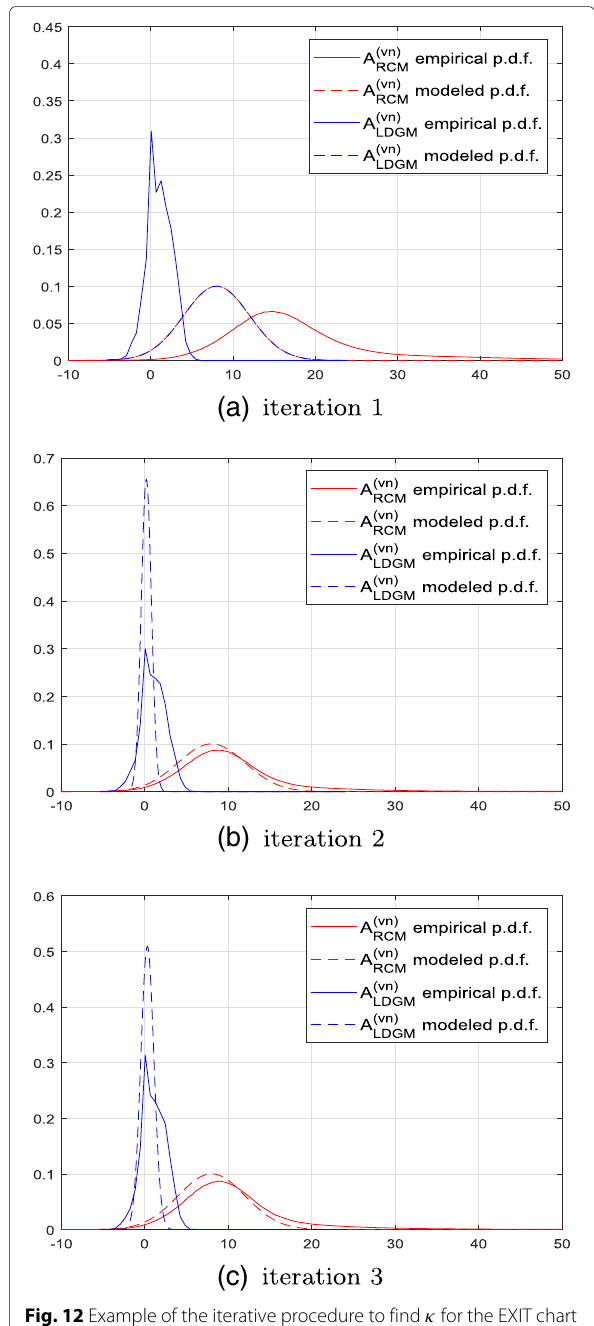
Fig. 12 Example of the iterative procedure to find κ for the EXIT chart of Fig. 8c. The histograms (conditioned to U = 1) obtained by Monte Carlo simulations are plotted in blue and the corresponding modeled conditional PDFs in red (refer to (11) and(12)). a Iteration1. b Iteration2. c Iteration